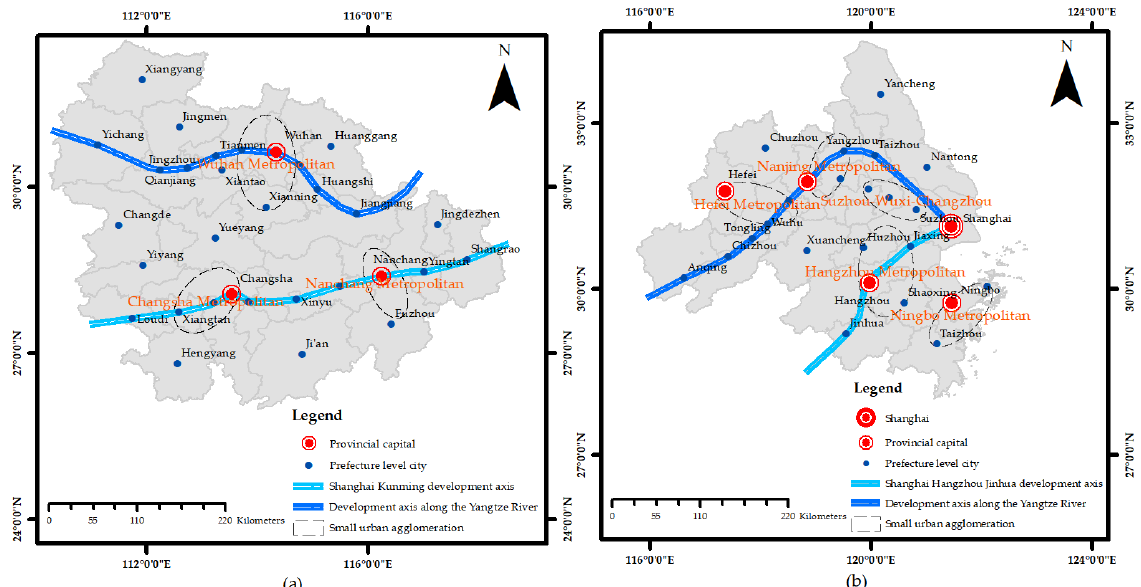
Figure 3. Urban agglomeration planning map of the middle and lower reaches of the Yangtze River. ( a ) The middle reaches of the Yangtze River urban agglomeration; ( b ) The Yangtze River Delta urban agglomeration. Table 1. Reference urban agglomerations and core